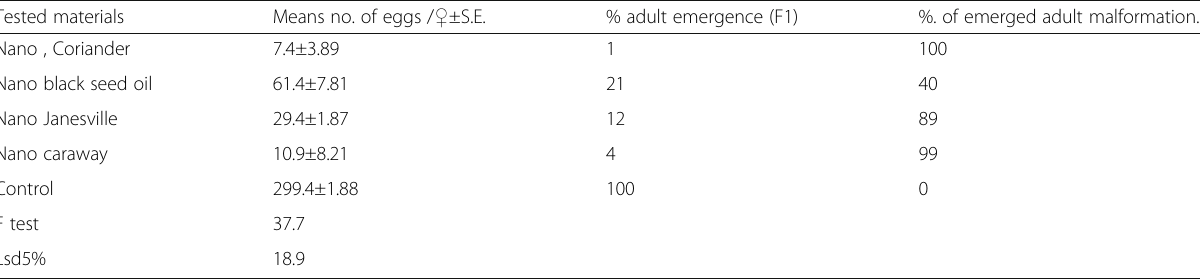
Table 3 Effect of the tested essential oils and nano-oils on eggs number laid per female and % of adult emergence (F1) of T. castaneum during storage periods Tested materials Means no. of eggs / ♀ ±S.E.